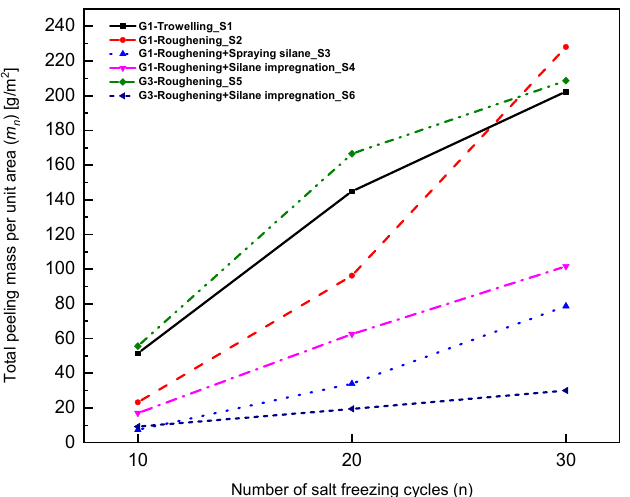
Figure 7. Variation of total spalling mass per unit area with the number of cycles.